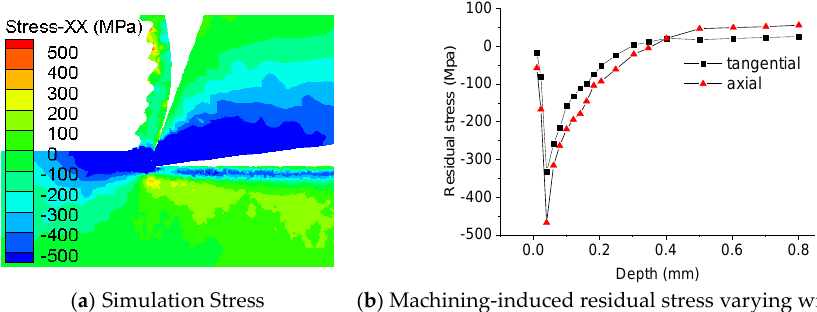
Figure 9. Residual stress after OD turning.